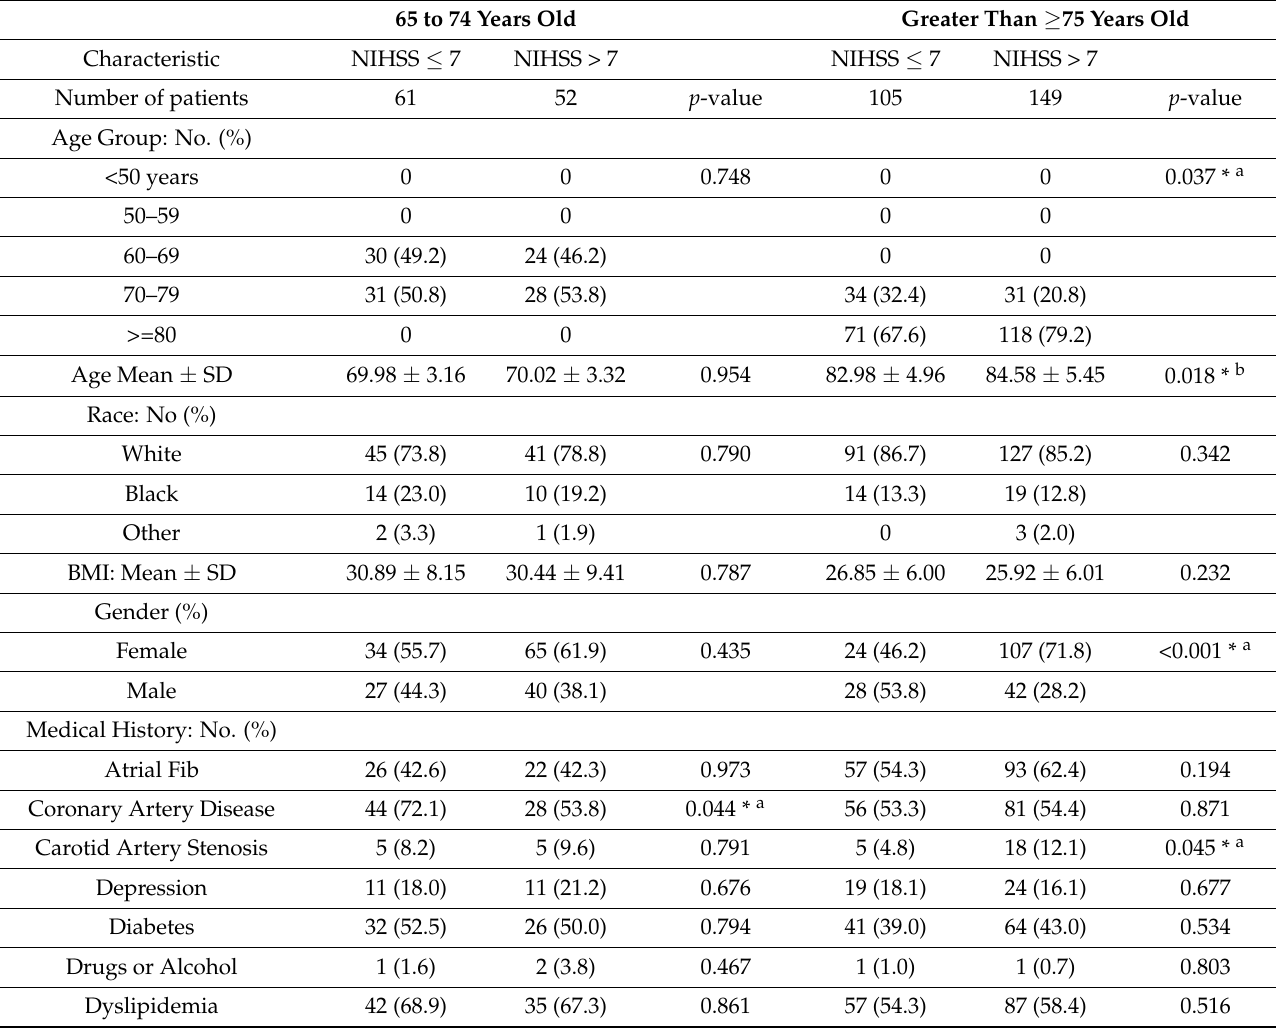
Table 1. Risk factors of acute Ischemic stroke patients with heart failure in patients 65 to 74 versus ≥ 75 years old are stratified by stroke severity. Comparison of Demographics and Clinical Charac- teristics of Acute Ischemic Stroke Patients with Heart Failure in patients who are 65 to 75 versus greater than 75 years old to evaluate for Stroke Severity. The continuous variables are represented as Mean ± SD, while discrete data are shown as